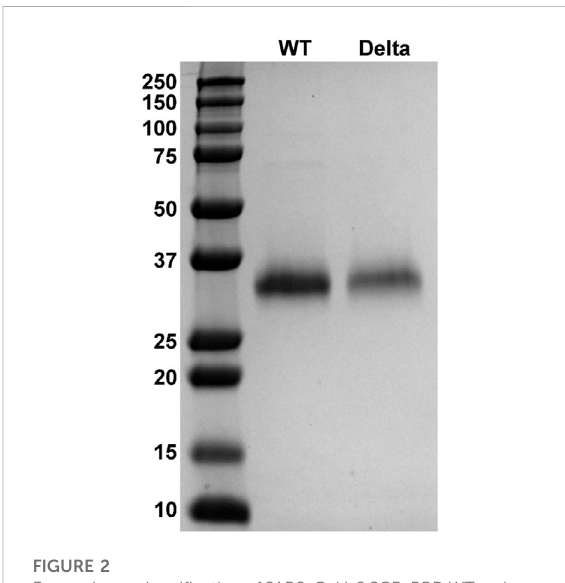
FIGURE 2 Expressionandpuri fi cationofSARS-CoV-2SGP-RBDWTand Deltavariant. Polyacrylamide gelelectrophoresis(PAGE)imagesof SGP-RBD WT, and Delta variants.